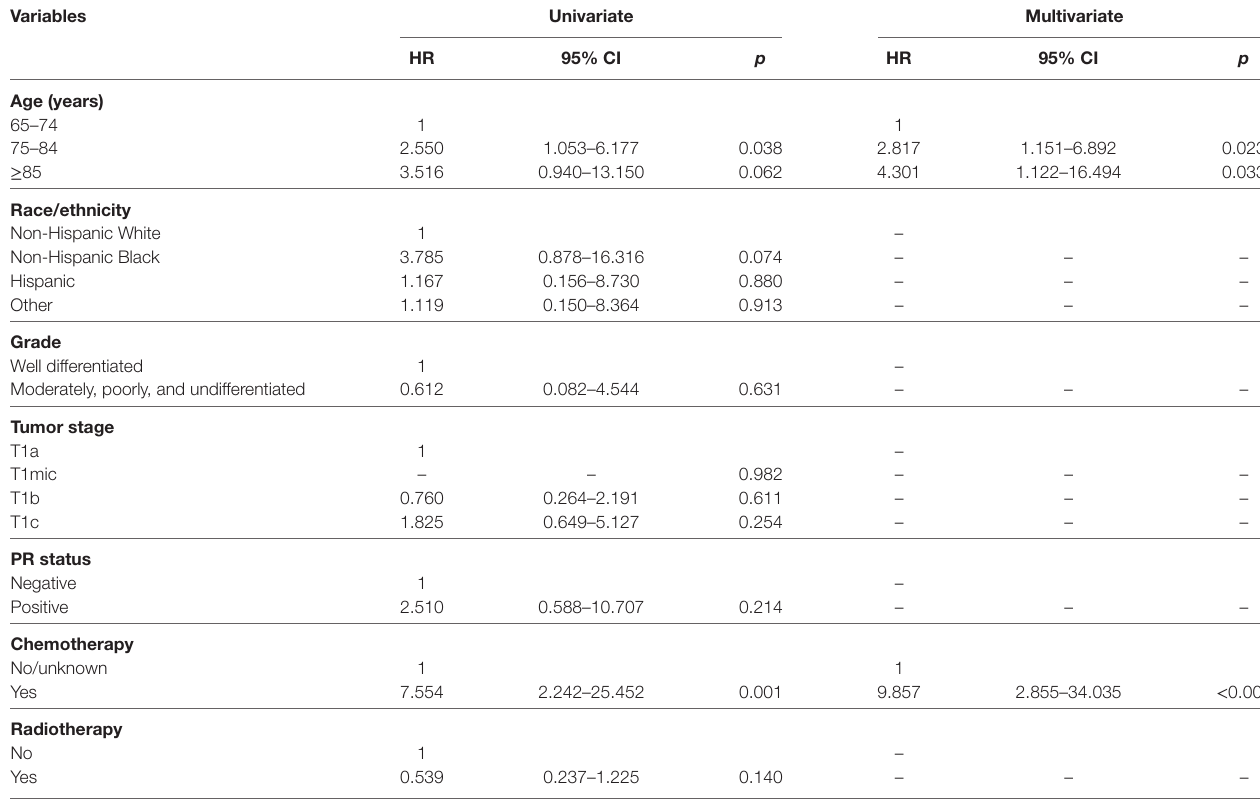
TaBle 3 | Univariate and multivariate prognostic analyses before propensity score matching.